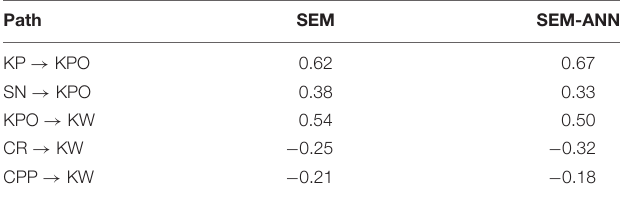
TABLE 7 | Comparison of knowledge withholding path coefficients between SEM and